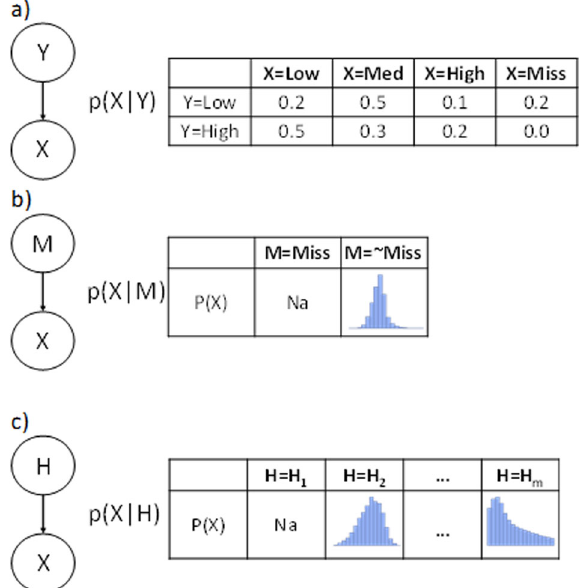
Fig. 6 Methods to capture missing data and unmeasured effects. a A binary “ Miss Node ” pointing to all continuous nodes in a Bayesian network. b A “ Miss State ” for discrete nodes. c A latent variable with m states to capture Missing Not at Random data and other unmeasured effects (in both discrete and continuous